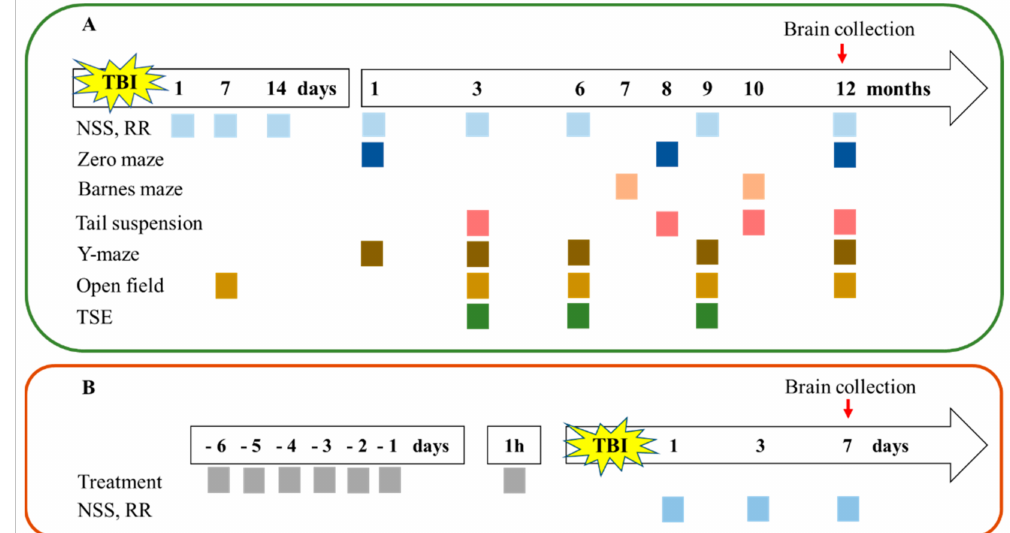
Figure 5. Schematic depicting the experimental design. ( A ) S1R-/- and WT mice were subjected to latFPI, and behavioral outcomes were assessed for up to 12 months postinjury. ( B ) BD-1063 was administered to evaluate the effects of pharma- cological blockade of S1R. Behavioral outcomes were evaluated for up to 7 days postinjury. Brain tissues were collected from animals in both experiments for histological analysis at the end point. TBI—traumatic brain injury, NSS—neurological severity score, RR—rota-rod, TSE—PhenoMaster behavioral